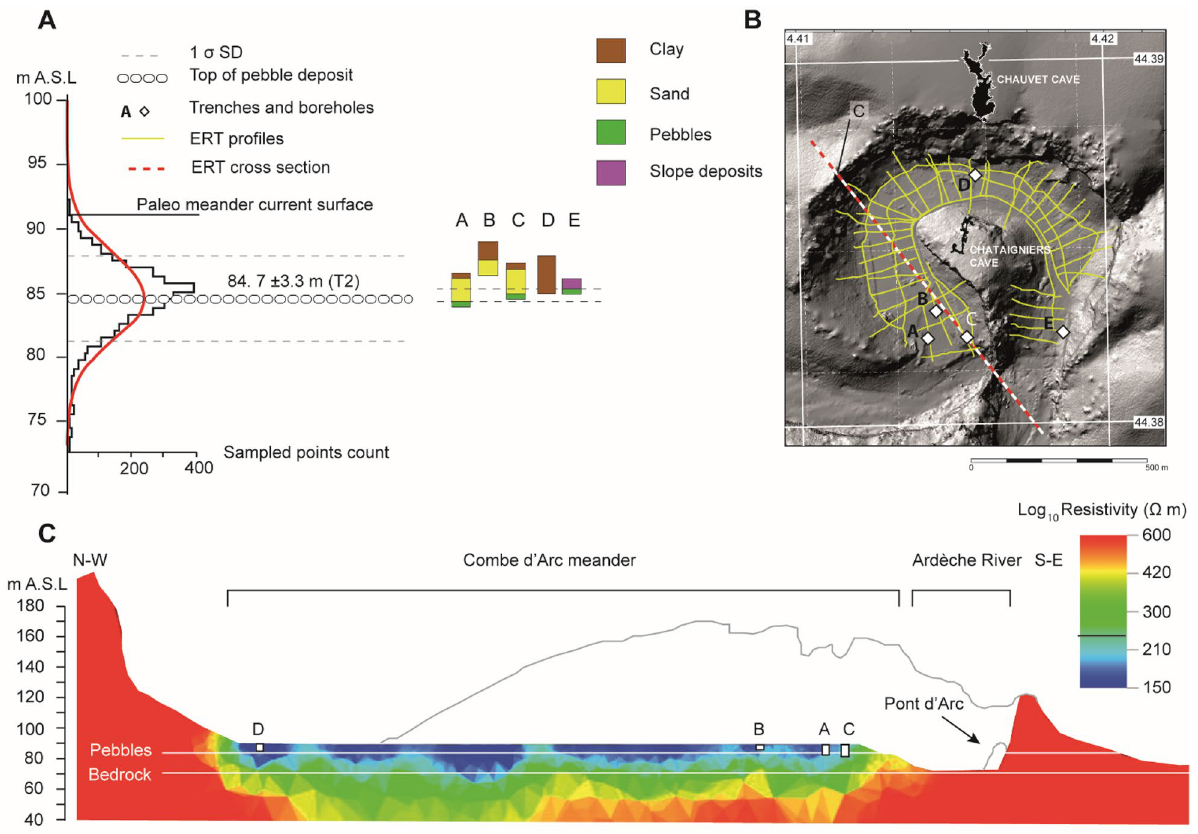
Figure 3. ERT survey inside the Combe d’Arc meander cutoff. Resistivity values for the meander sediments ranged from 150 to 600 Ωm. ( A ) Mean altitude of cutoff cobble layer. ( B ) Location of the ERT cross-sections. ( C ) Cross-section of the meander cutoff showing resistivity